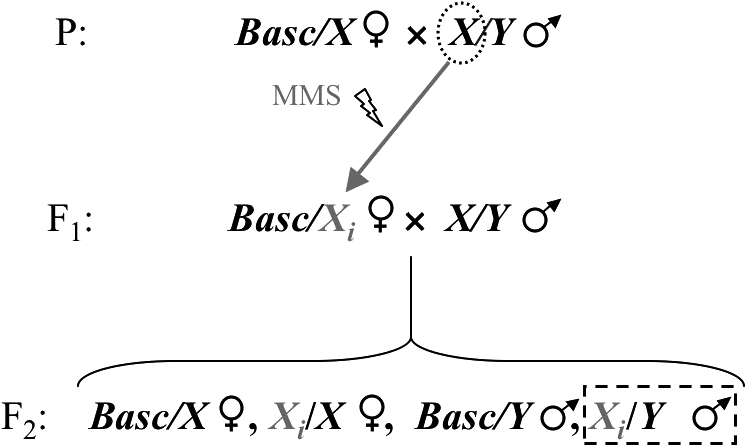
Crossing Design for Detection of Sex-Linked Recessive Lethal MutationsIn the parental cross, high- or low-condition females of genotype Basc/X were mated to wild-type males who had been mutagenized with MMS. From each mother, four to ten F1 daughters were placed in individual vials to lay eggs. Each of these daughters carried a paternally inherited (mutagenized) X chromosome, denoted as Xi in grey. These females had been allowed to mate with their brothers, which means they could have mated to either X/Y or Basc/Y males though offspring arrays indicate that it was usually the former as depicted here. Regardless of the F1 male, 25% of the F2 offspring are expected to be Xi / Y (wild-type) males (shown in dashed box). However, if there is a recessive lethal (or near lethal) on Xi, then Xi / Y males will be absent or very rare. We attempted to classify each Xi as carrying a (near) lethal or as not doing so, depending on the likelihood of obtaining the observed frequency of Xi / Y males when the expected frequency was 25% (no lethal) relative to the likelihood when the expected frequency was 2.5% (near lethal). If there was not sufficient evidence from the distribution of F2 progeny to classify an Xi in either of these two categories, then that Xi was excluded from further analysis. See Materials and Methods for details.